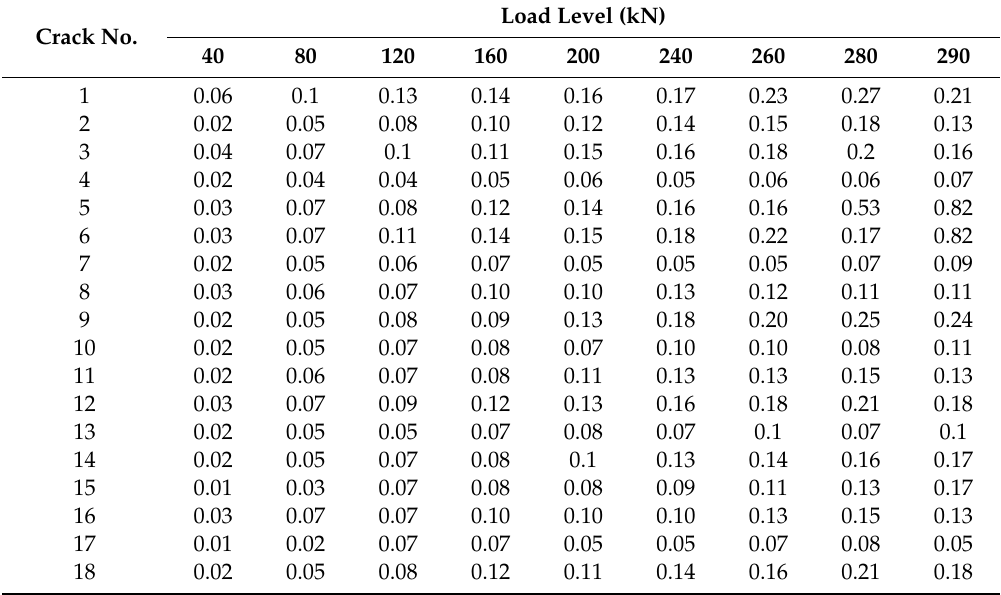
Table 2. Crack width of tested beam under di ff erent load level